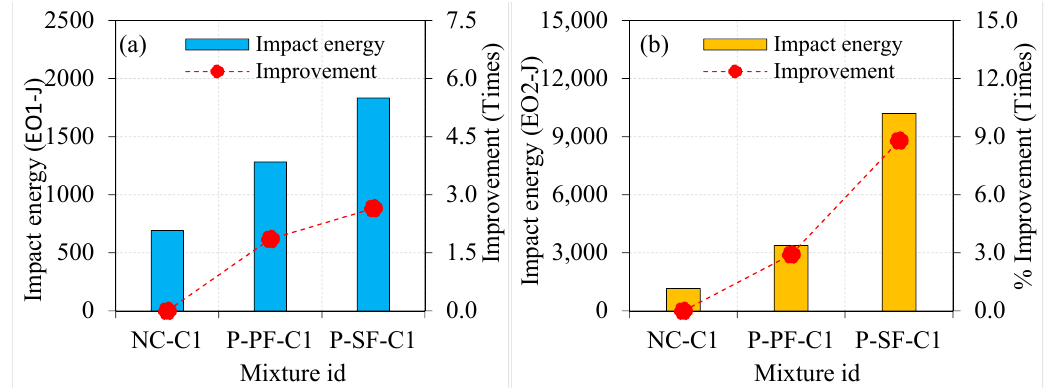
Figure 14. Effect of fibres on single-coated aggregate specimens ( a ) EO1 and ( b ) EO2.